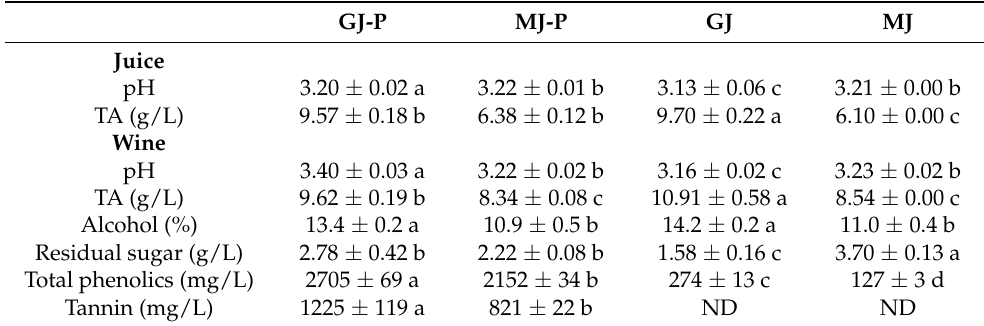
Table 1. General oenological